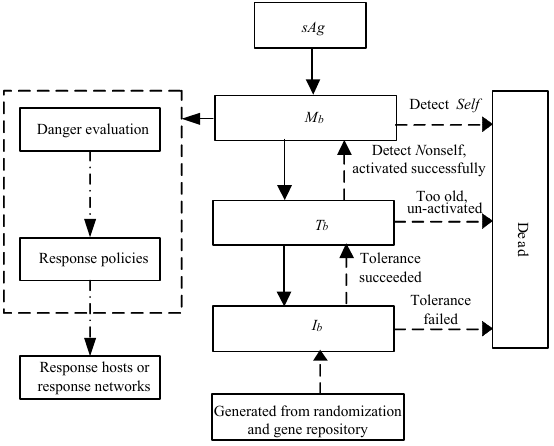
Fig. 1. The workflow of MAIM . The dashed line represents the moving direction of detectors, the solid line represents the moving direction of Ag , and the dashdotted line is the flow of response